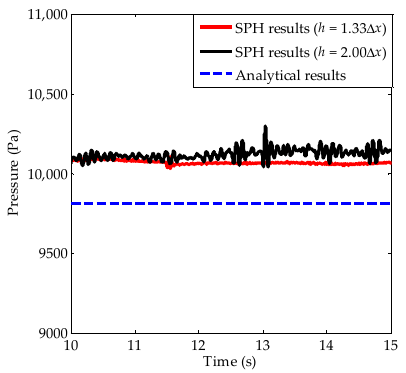
Figure 7. Pressure histories at the pressure sensor.